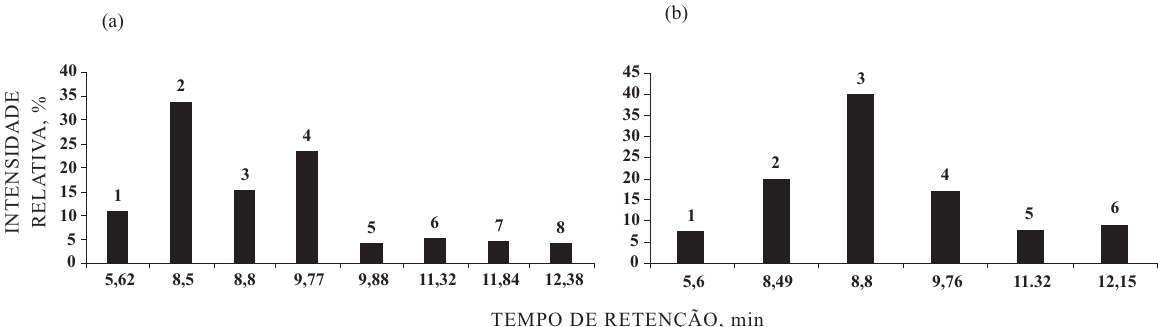
Figura 5. Percentagem relativa dos compostos orgânicos da subfração aromática presentes na humina extraída de amostras de solo degradado pela extração de argila, com vegetação espontânea [ Brachiaria mutica (Forsk.) Stapf] (A) e em área com Acacia mangium Willd (B). Os números nas barras dos gráficos referem-se aos picos correspondentes dos